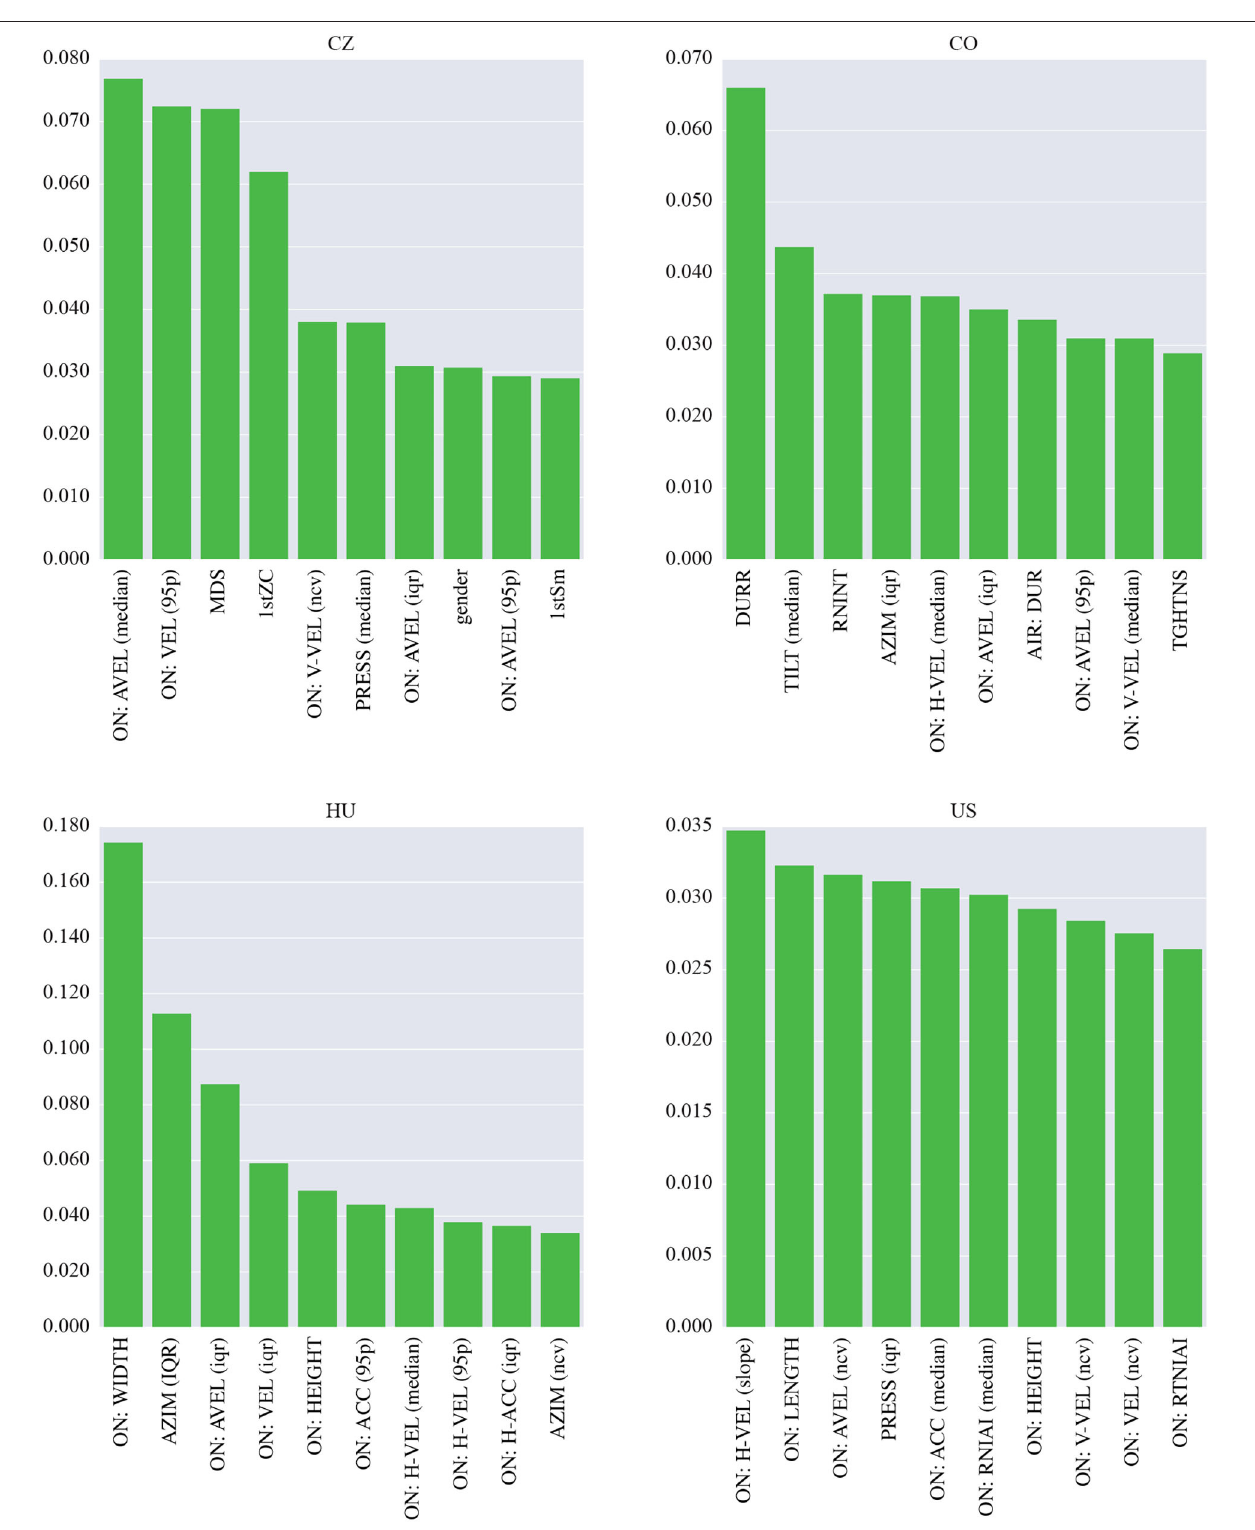
Frontiers in Neuroinformatics |